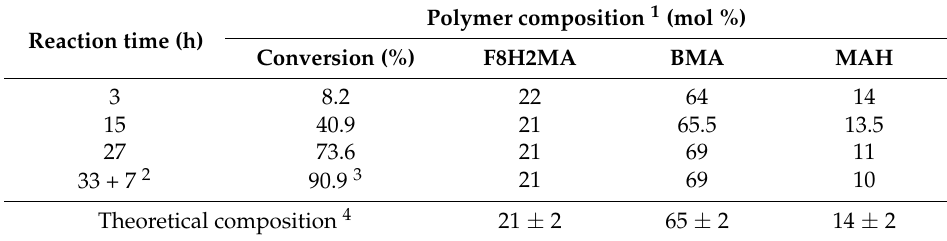
Table 5. Compositions of the copolymer samples taken during the continuous addition experiment (copolymer C1).